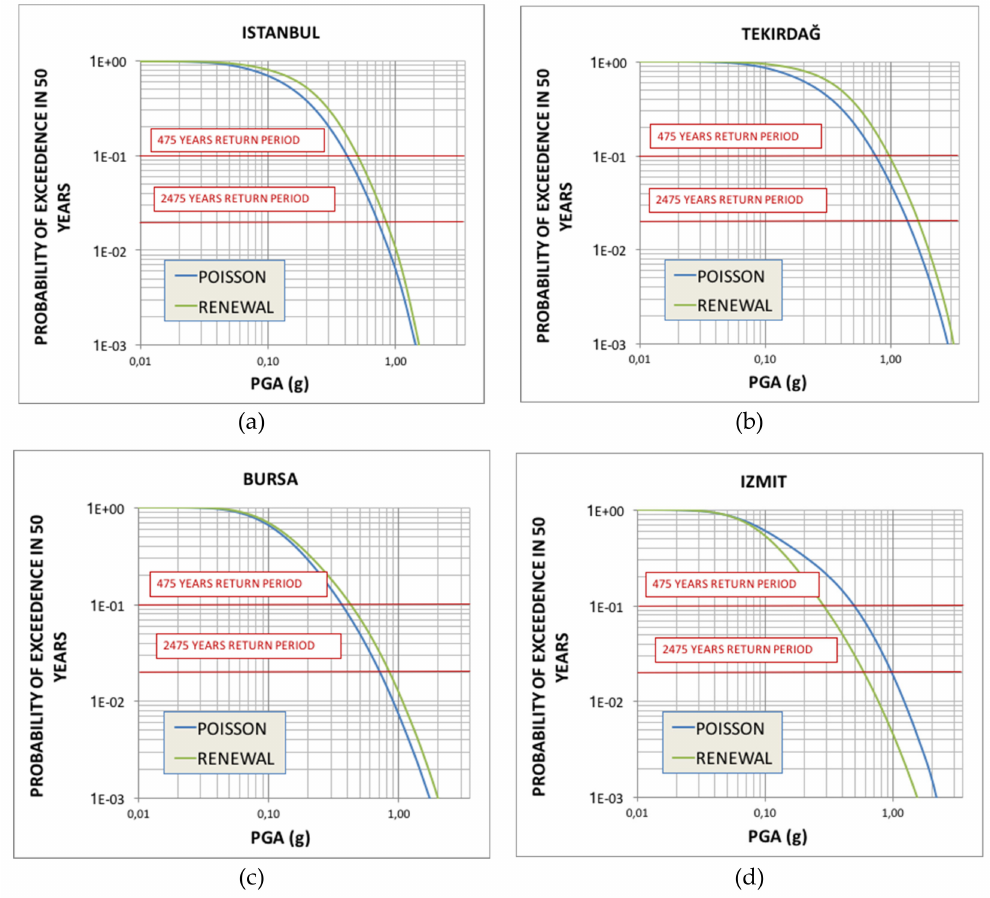
Figure 23. PGA hazard curves for ( a ) Istanbul, ( b ) Tekirda˘g, ( c ) Bursa, and ( d ) Izmit (Kocaeli) obtained from Poisson and renewal models, both combined with smoothed seismicity at the